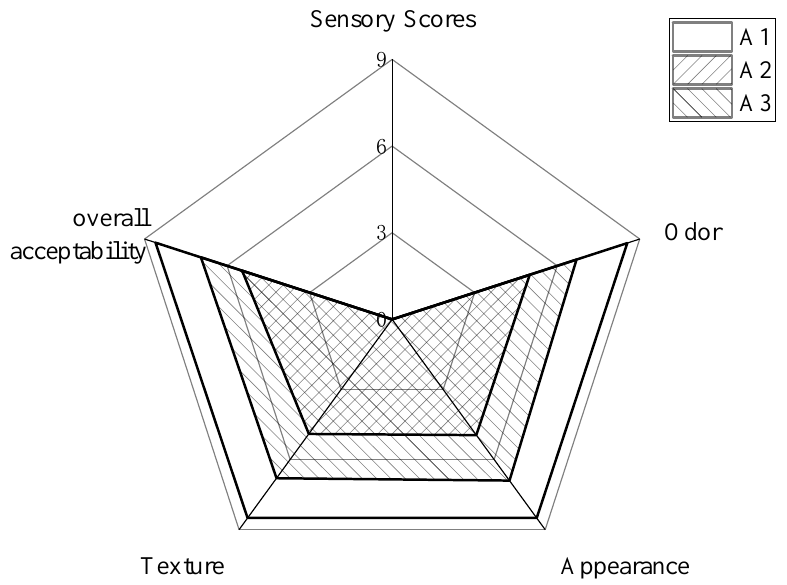
Figure 1. Radar chart of sensory scores for the quality attributes of tuna Figure 1 . Radar chart of sensory scores for the quality attributes of tuna samples .